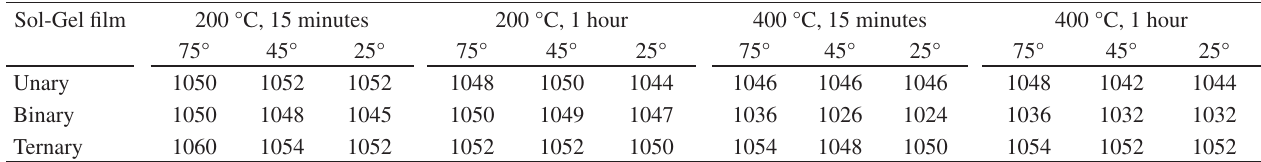
Table 1. Shift in the Si-O-Si peak (cm -1 ) caused by addition of phosphorous in unary, binary, and ternary sol-gel films. Sol-Gel film